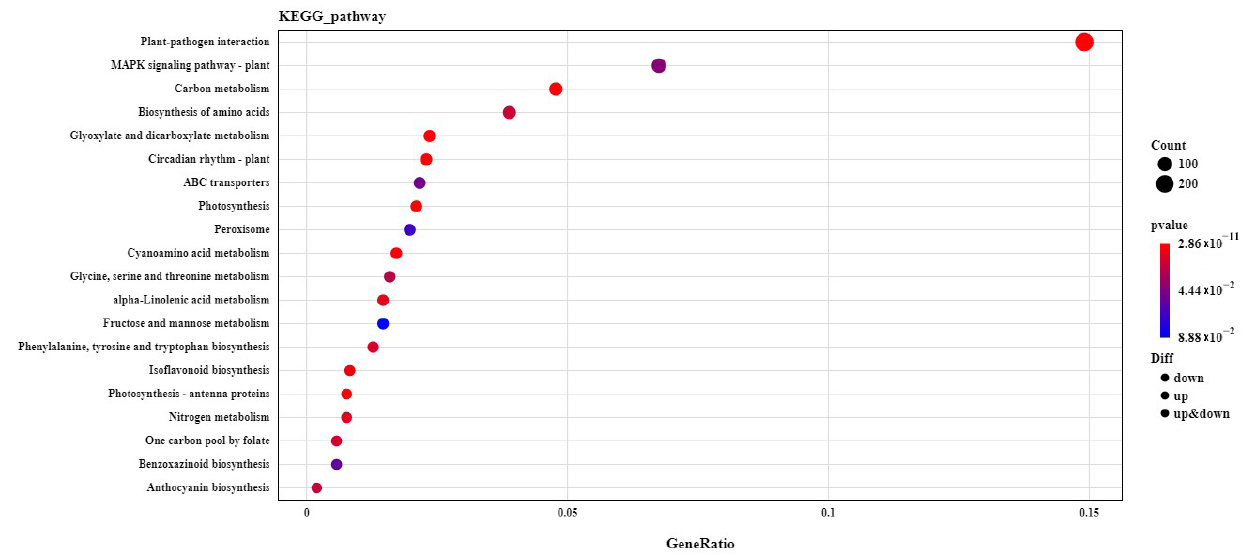
Figure 5. KEGG pathway enrichment analysis in the non-transgenic plants versus the transgenic